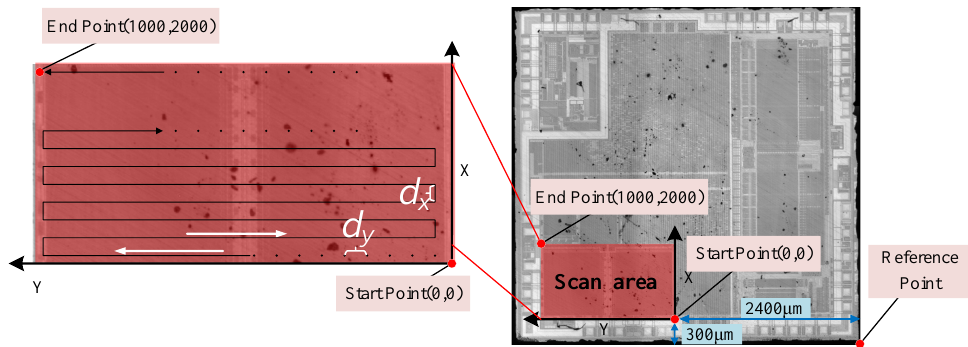
Figure 8: The laser scan trajectory to cover full area of the SRAM. The lower right corner of the chip is chosen as the reference point. A total area of 1000 µm × 2000 µm will be scanned to cover the